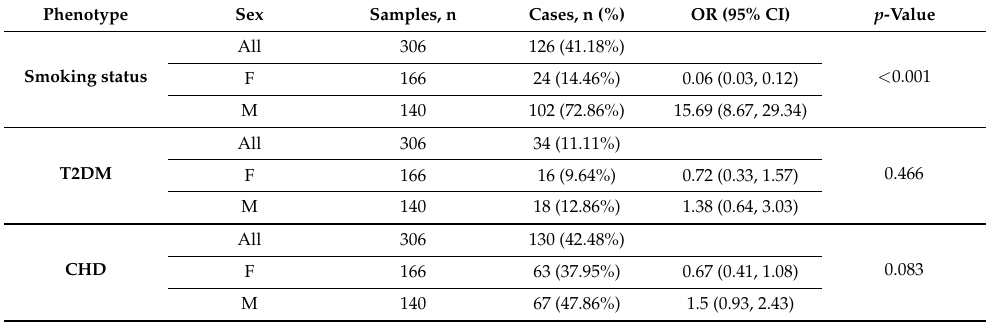
Table A3. Summary of binary phenotypes. Being case means having phenotype. Smoking status cases correspond to current or former smokers. p -values and odds ratios (with corresponding 95% confidence intervals) obtained from the Fisher’s exact test testing difference in ratio of each class of the variable between male and female groups ( H 0 : classification for given binary variable for male and female groups are not